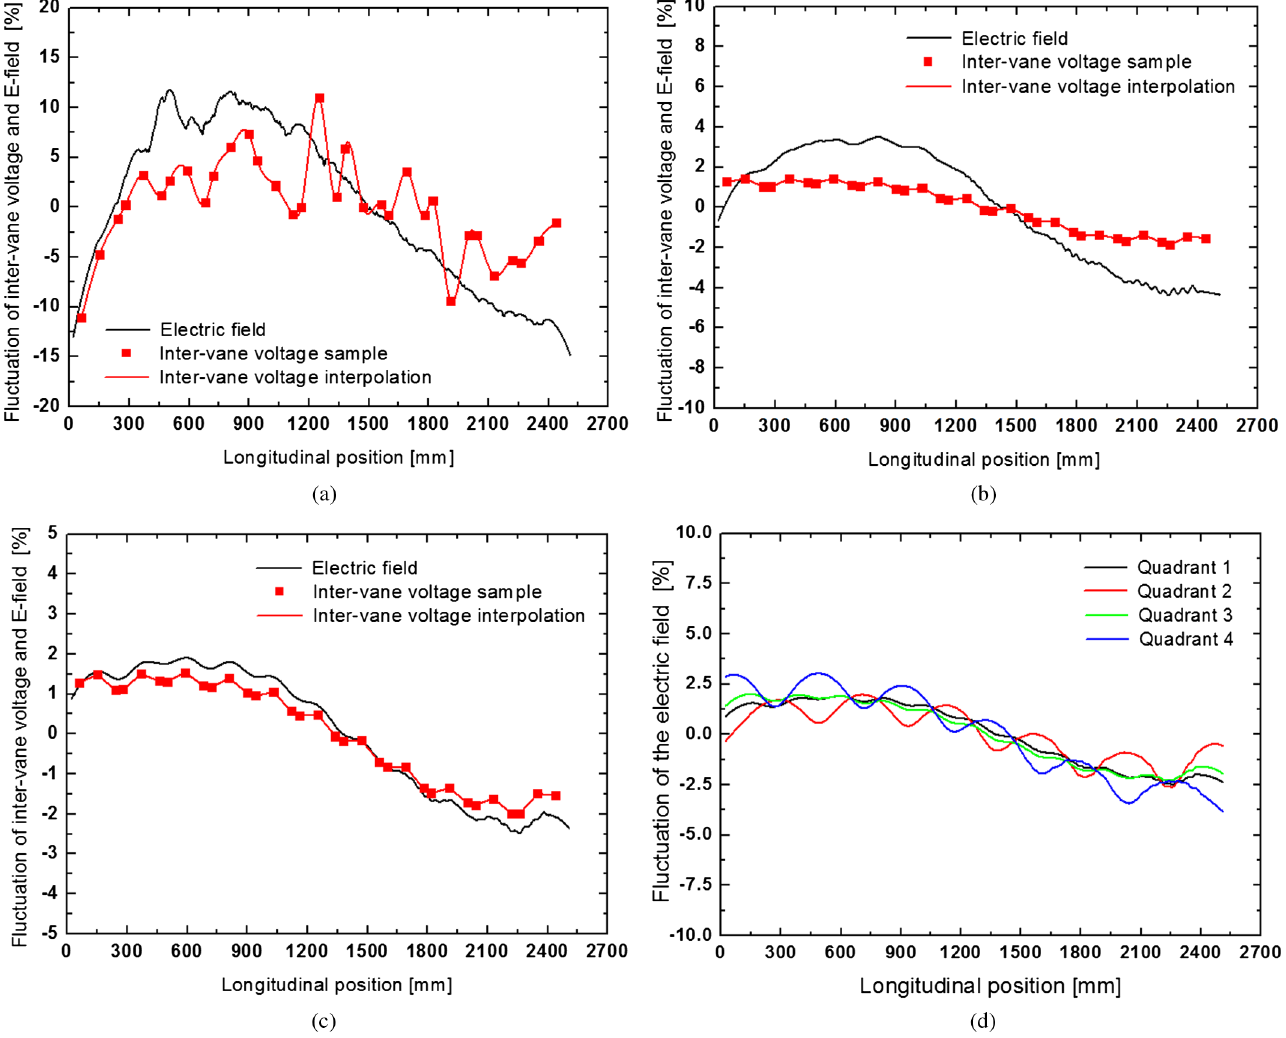
FIG. 10. The simulated field flatness at various transverse